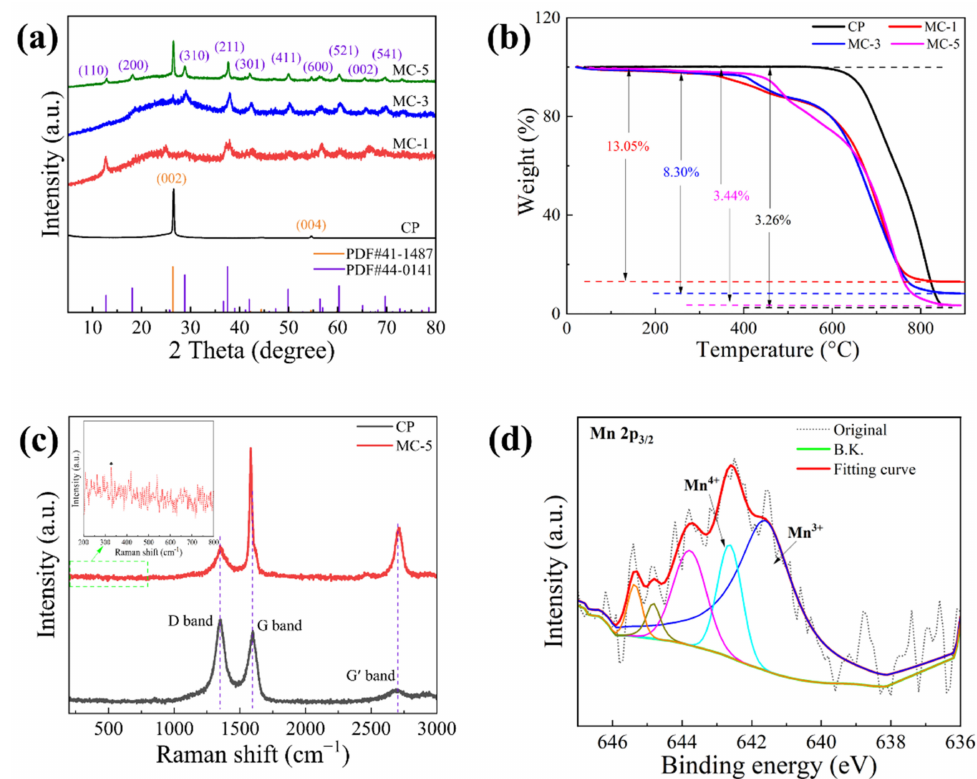
Figure 3. X-ray diffraction patterns ( a , b ) and TG curves of CP, MC-1, MC-3, and MC-5. Raman spectra of CP and MC-5 ( c ). ( d ) Mn 2p 3/2 spectra of the pristine MC-5. Raman spectrum is adopted to further explore the effect of the loaded MnO 2 on CP. The pristine CP has the typical D peak, G peak, and 2D peak (Figure 3c), which are located at 1355 cm − 1 , 1598 cm − 1 , and 2689 cm − 1 , respectively. The corresponding ratio of ID/IG is calculated to be 1.17, which signifies some existing defects in the CP [46]. In contrast, MC-5 possesses the D peak, G peak, and 2D peak at 1349 cm − 1 , 1582 cm − 1 , and 2717 cm − 1 , respectively, with an I D /I G ratio of 0.25. The significant decrease of I D /I G by decorating MnO 2 on CP indicates the enhanced graphitization with fewer defects, which a small characteristic peak of Mn-O bond occurs at ~327.5 cm − 1 in the inset figure [48]. The Mn 4+ at 642.6 eV and the related three satellite peaks at 643.8 eV, 644.8 eV and 645.4 eV [37], while some Mn 3+ at 641.6 eV exist in the prepared MnO 2 , which may be the intermediate reaction products on the MnO 2 surface